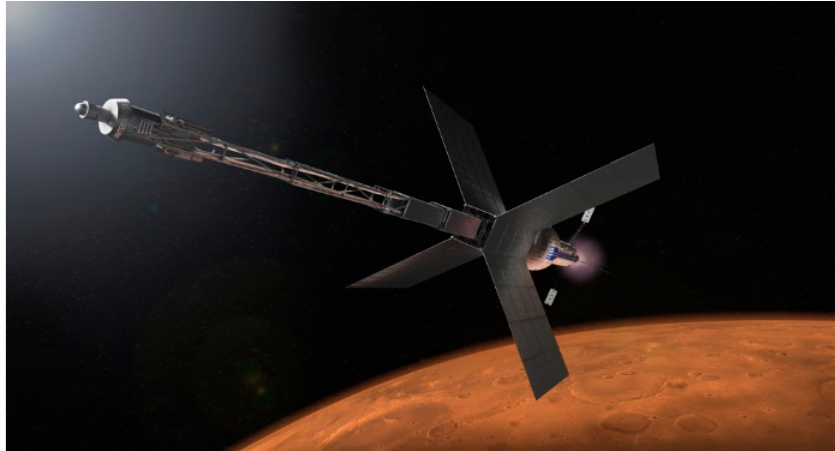
Figure 5. Illustration concept of a Mars nuclear propulsion system with transit habitat.